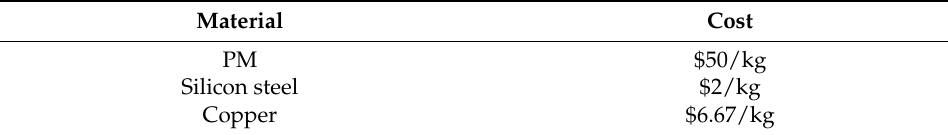
Figure 8. Point-based optimisation flow chart. Table 5. Costs of